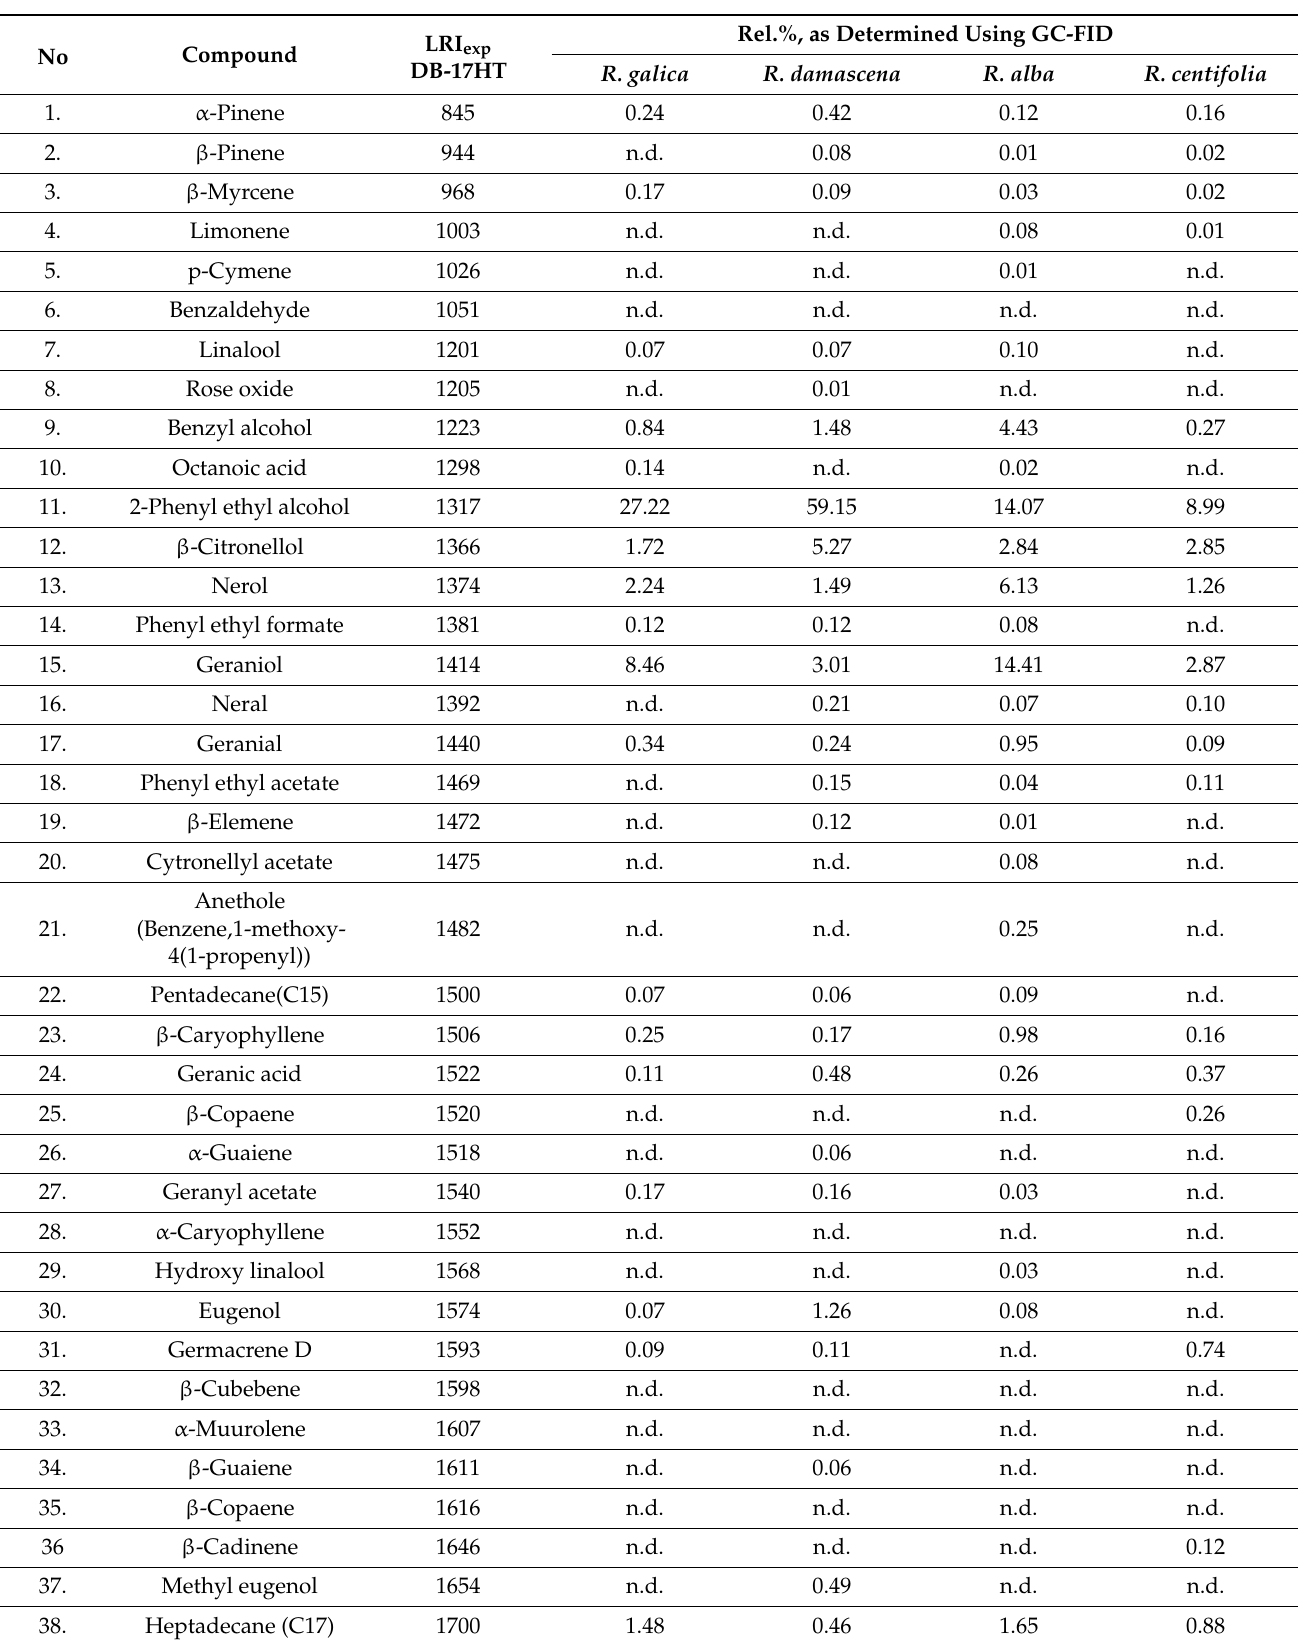
Table 1. Chemical composition of R134a rose extracts, as determined using GC/MS/FID on a DB-17HT